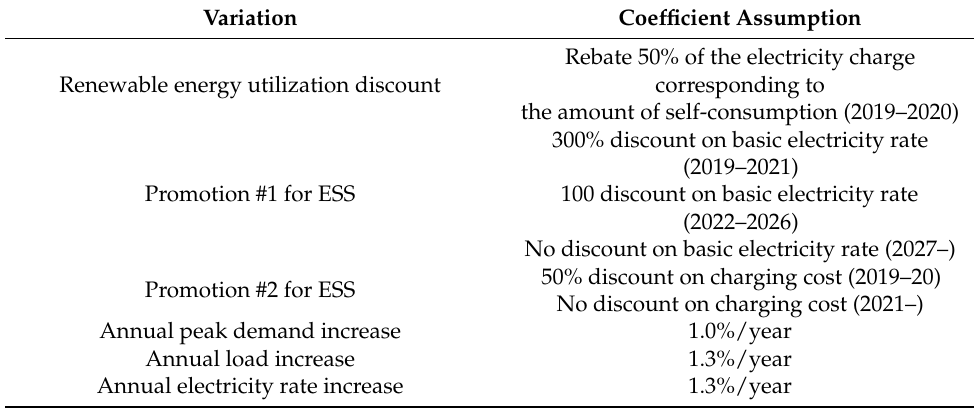
Table 6. Coefficient for variation of rate applicable to distributed energy